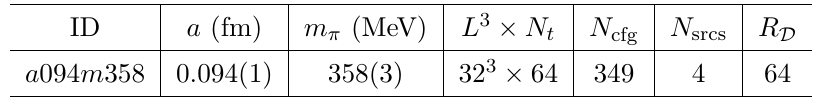
Table 1. Lattice ensemble employed in this work. The number of distinct source positions N srcs per configuration and the distillation space rank R are also indicated. We note the resulting D number of measurements N = N = 1396 is kept fixed for all two- and three-point meas cfg × N srcs functions computed in this work, regardless of momentum boost, source-sink separation and Wilson line